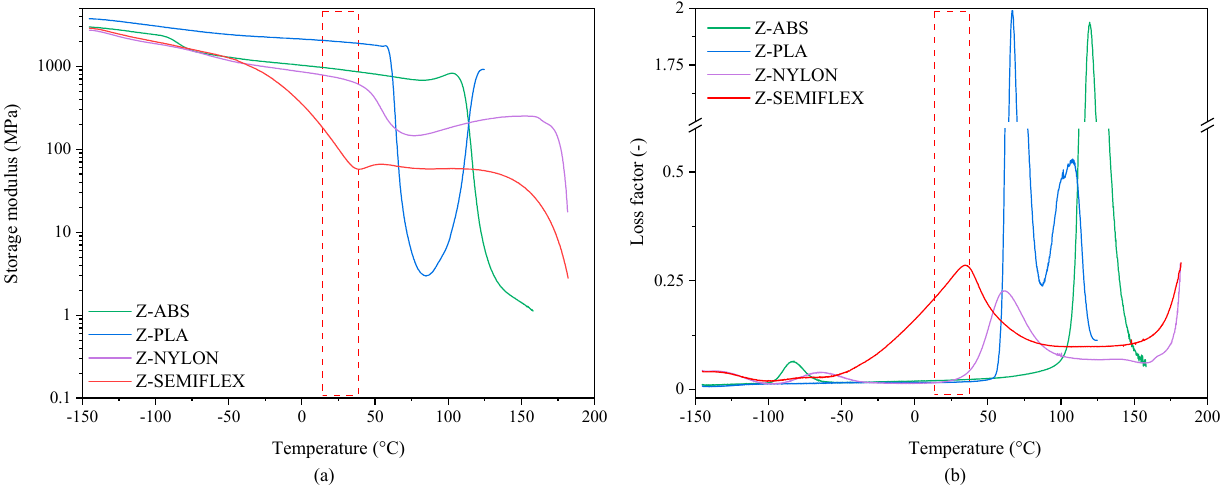
Figure 4. Temperature dependance of storage modulus ( a ) and tan δ ( b ) for Z-ABS, Z-PLA, Z-NYLON and Z-SEMIFLEX. Table 5. Selected properties determined from DMTA analysis.